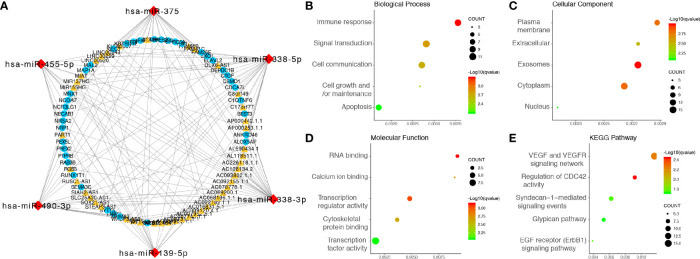
Integrated analysis of the ceRNA network. (A) ceRNA network, the yellow triangles represent 45 lncRNAs, the red diamonds represent six miRNAs, and the blue dots represent 38 mRNAs. (B) Biological processes enriched in DE-RNAs. (C) CCs enriched in DE-RNAs. (D) MFs enriched in the DE-RNAs. (E) KEGG pathways enriched in the DE-RNAs. KEGG, Kyoto Encyclopedia of Genes and Genomes.